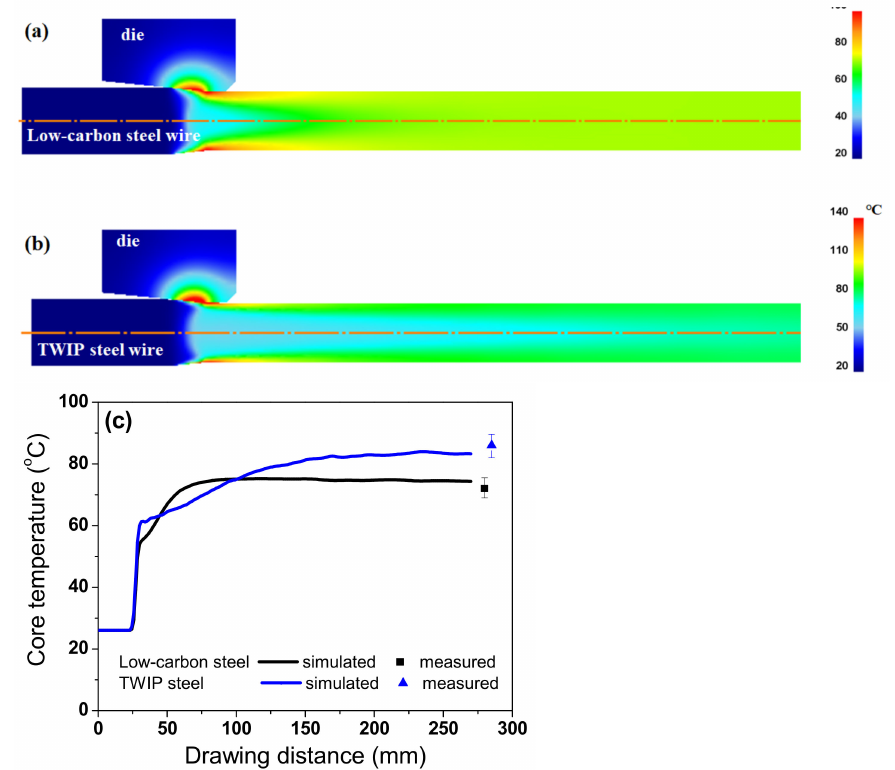
Figure 8. Comparison of temperature contour of ( a ) low-carbon steel and ( b ) TWIP steel, and ( c ) equilib- rium core temperatures between experiment and FEA of two